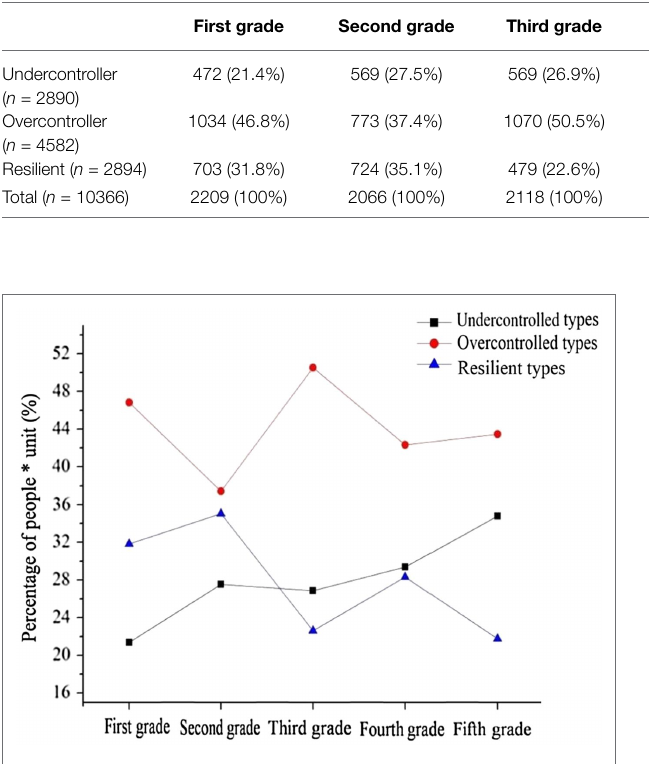
FIGURE 4 | Developmental trends of primary school students’ personality